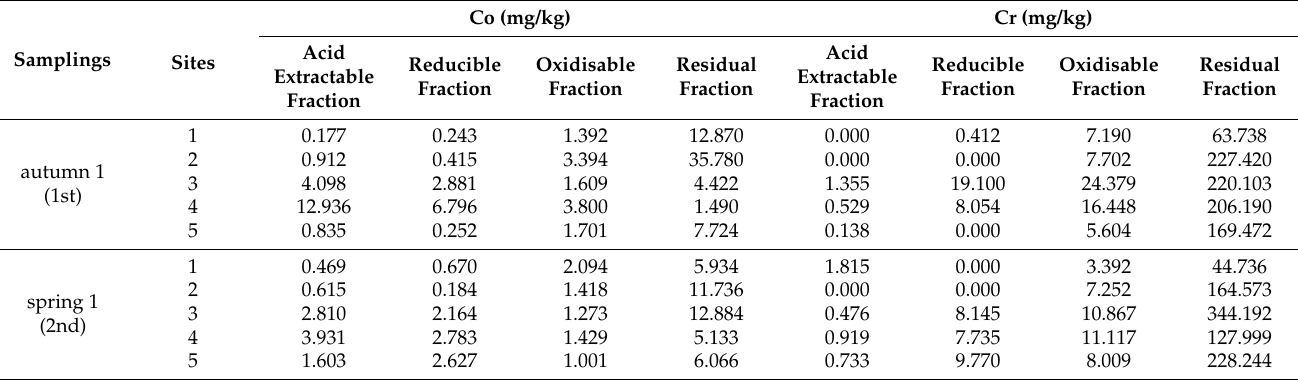
Table A4. Concentrations of Co (mg/kg) and Cr (mg/kg) in the different fractions of sediments from Algeciras Bay.